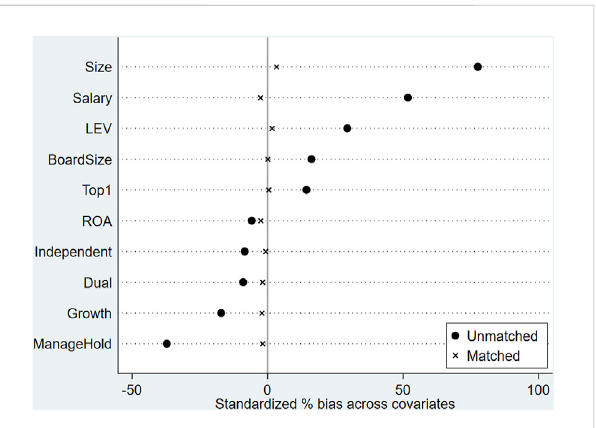
FIGURE 1 This fi gure shows the diagram of the standardized deviation of each control variable: fi rm size ( Size ), return on total assets ( ROA ), fi nancial leverage ( LEV ), growth rate ( Growth ), ownership concentration ( Top 1), integration of two positions ( Dual ), board size ( BoardSize ), independent director ratio ( Independent ), top three executives ’ compensation ( Salary ), and management shareholding ratio ( ManageHold